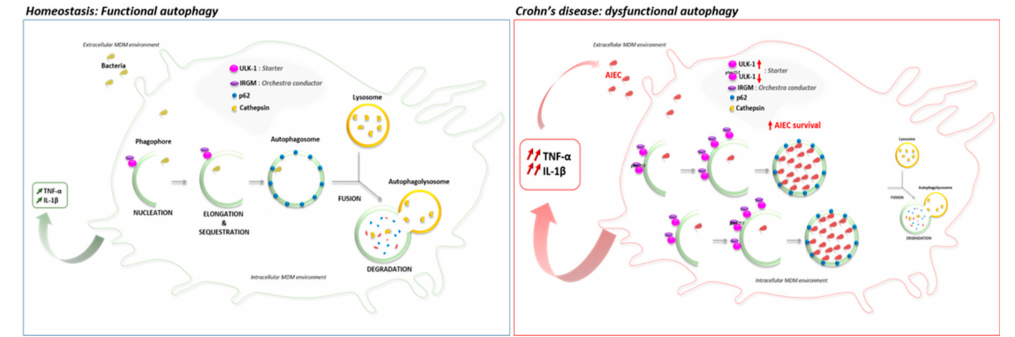
Figure 6. Proposed model of autophagy and cytokines secretion’s role in macrophages infected by AIEC bacteria from Crohn’s Disease patients. In homeostasis state, the internalized bacteria are in part addressed to the functional autophagic process to be degraded by the cathepsins. However, in macrophages from Crohn’s disease patients, the ULK-1 activity increase may lead to an exacerbated dysfunctional autophagy in favor to the AIEC internalization and survival into the autophagosome. In response to AIEC infection, the deficient macrophages secrete an excessive inflammatory cytokine such as, TNF- α and IL-1 β , that then benefit to the internalization of AIEC, triggering a detrimental loop of chronic inflammation.